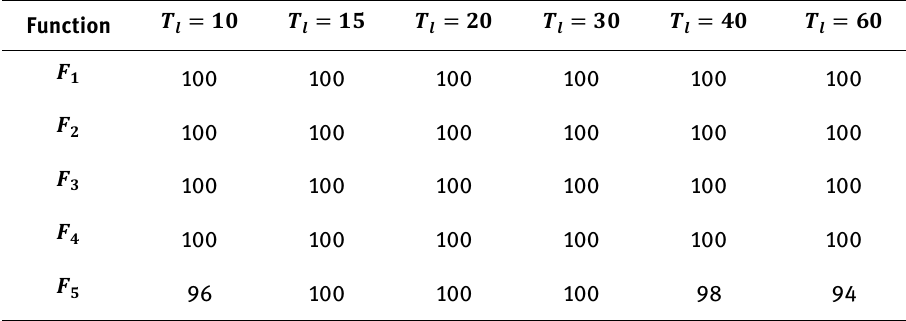
Table 8A: Success rate of the KGSA for the different values of T